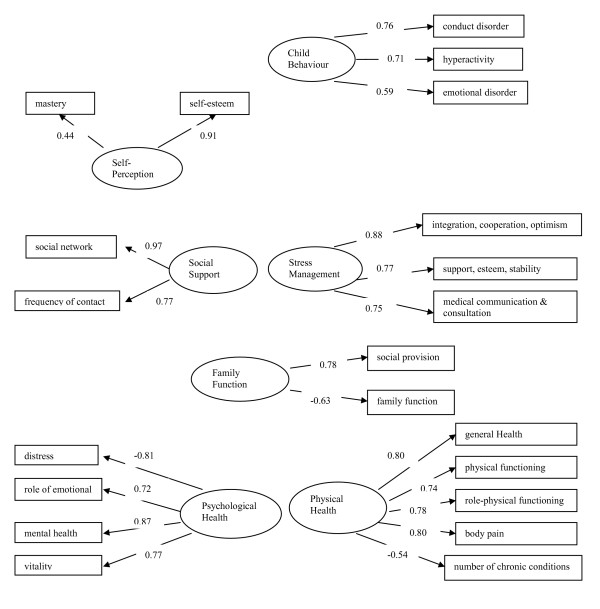
Measurement model: standardized factor loadings of observed variables (rectangles) on latent variables (ellipses). The loadings of 'Caregiving Demands' and 'Gross Income' were not estimated as a loading can not be estimated when there is a single indicator for a construct (not shown). Each construct (latent variables and two single indicators) is connected to every other by a curved, two-headed arrow, meaning that every construct is allowed to covary with every other construct.